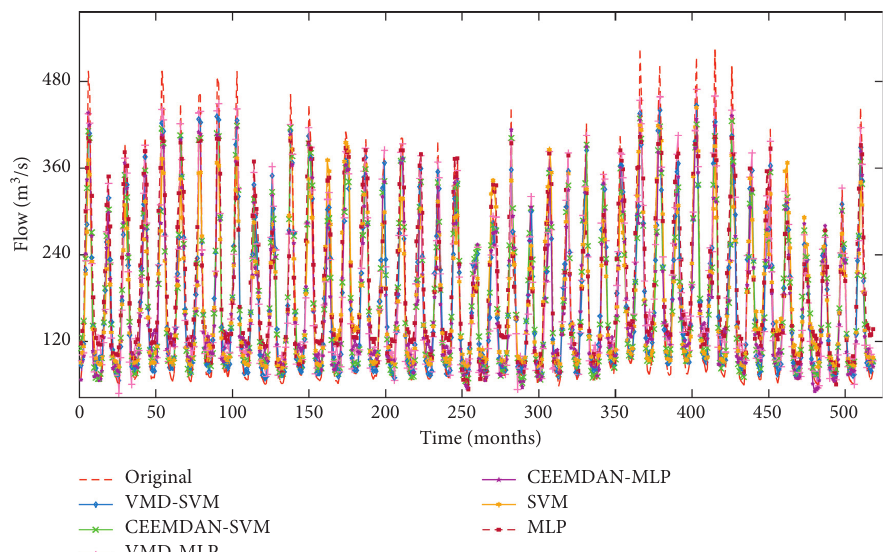
Figure 9: Observed and predicted runoff during the model training period using VMD-SVM, CEEMDAN-SVM, VMD-MLP, and CEEMDAN-MLP models.